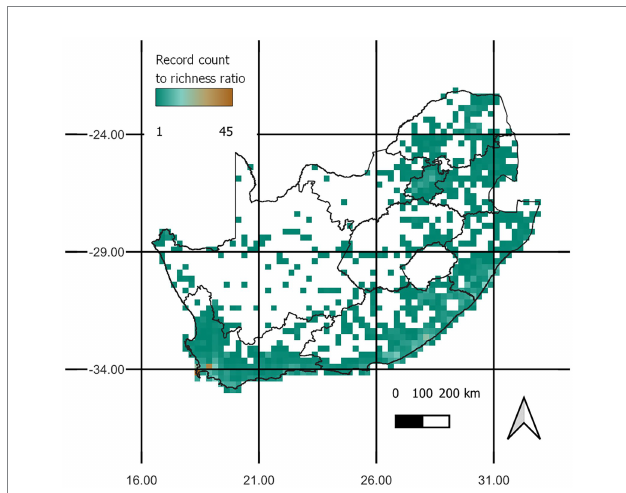
FIGURE 2 The record count of focal species per grid cell divided by the species richness per grid cell highlights the distribution of multiple records per focal species in the study